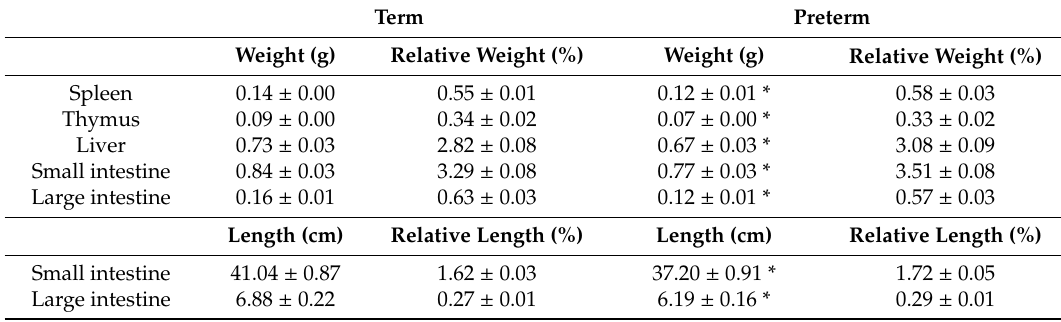
Table 1. Absolute and relative weight of spleen, thymus, liver, small and large intestines, and length and relative length of small and large intestines from term and preterm groups at day 10.